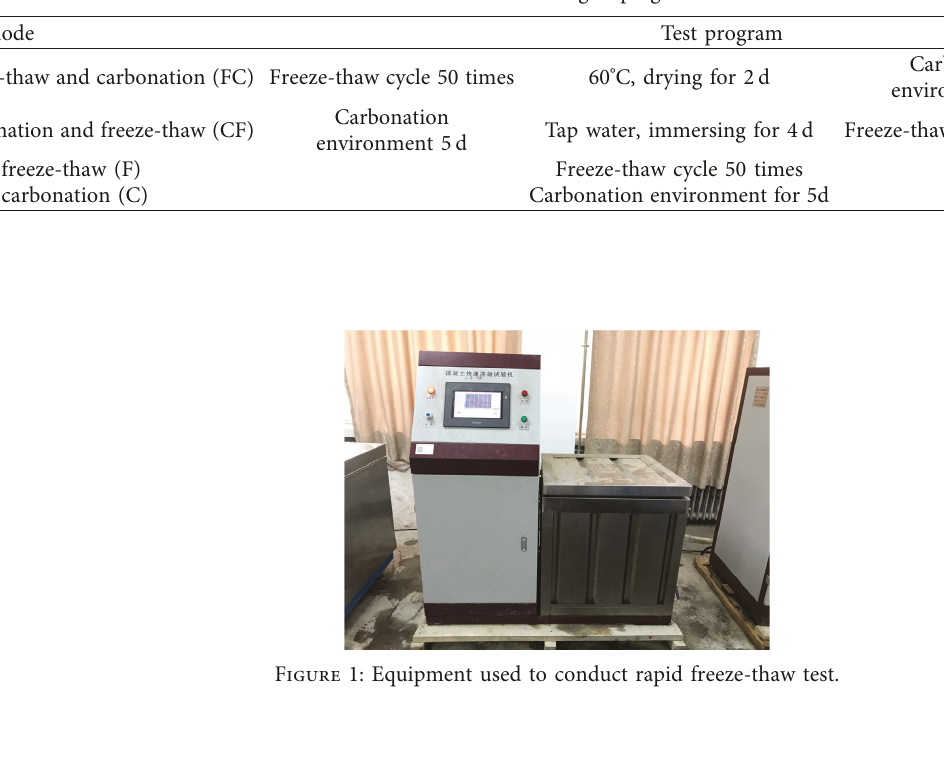
Table 4: Test grouping.